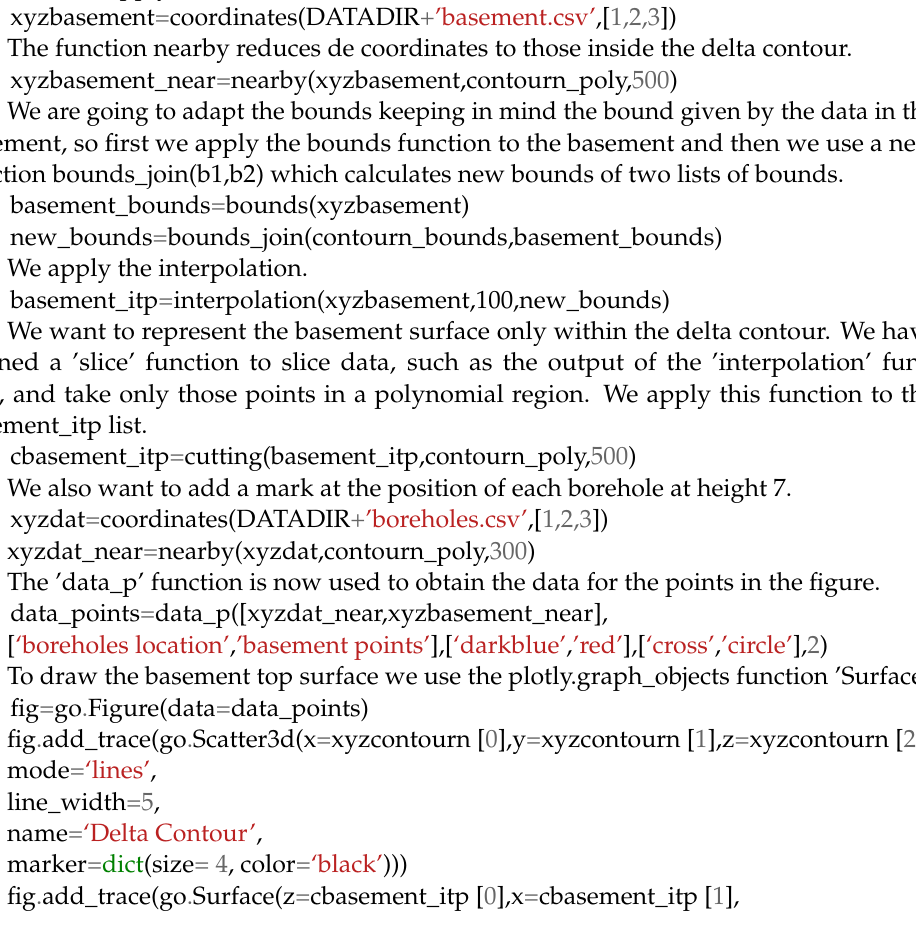
fig.add_trace(go.Surface(z=cbasement_itp [0],x=cbasement_itp